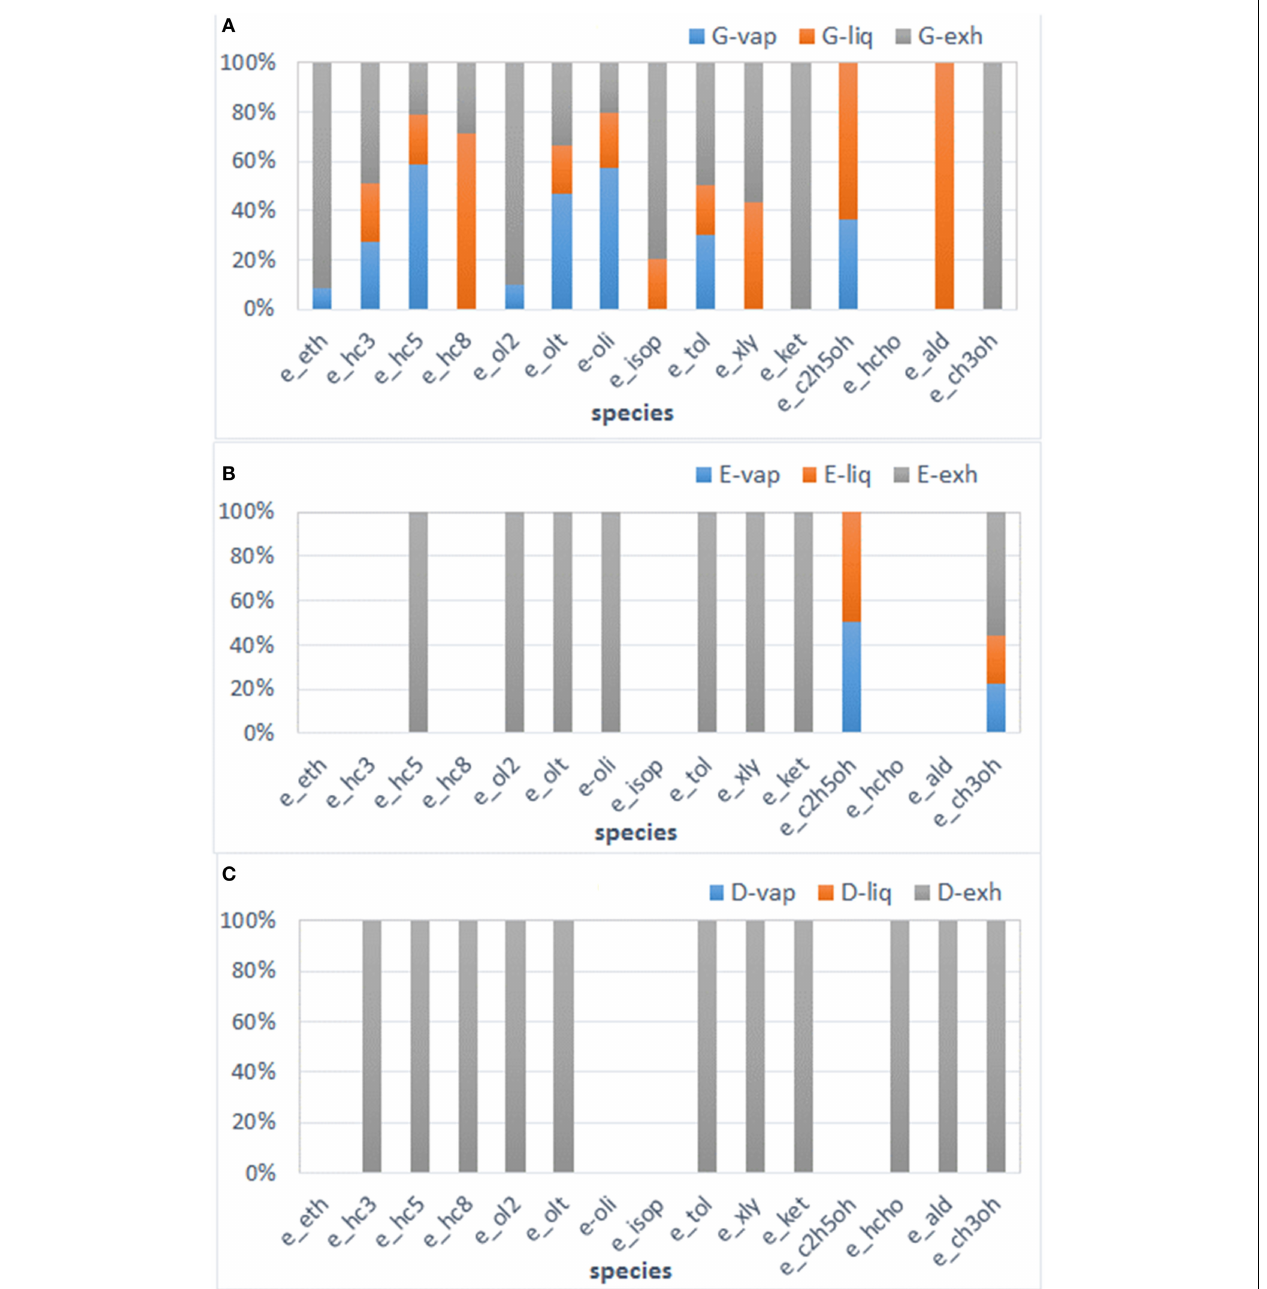
FIGURE 6 | VOC fractions for exhaust, evaporative, and liquid emissions from gasohol (A), ethanol (B), and diesel (C). G, gasohol; E, ethanol; D, diesel; -vap, evaporative; -liq, liquid; -exh, exhaust; e_eth, ethane and alkanes with kOH < 0 . 5 × 10 3 ppm − 1 min − 1 ; e_hc3, propane and alkanes with kOH 0 . 5 × 10 3 –5 . 0 × 10 3 ppm − 1 min − 1 ; e_hc5, alkanes with